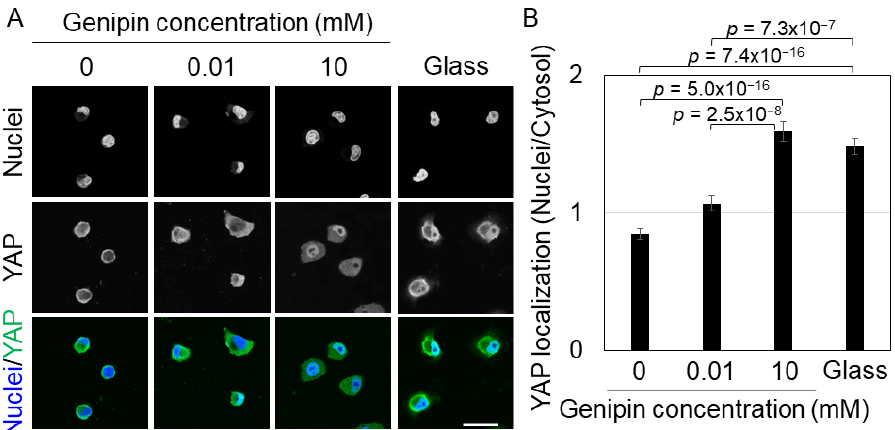
Figure 3. ( A ) Fluorescent staining of nuclei and YAP of H1299 cells on the 0, 0.01, or 10 mM genipin- mixed collagen gels or collagen-coated glass substrates. Scale bar = 50 μ m. ( B ) YAP localization of H1299 cells shown in ( A ). Mean ± S.E. N = at least 84 cells in 4 independent experiments. p value was calculated using Welch’s t -test with Bonferroni